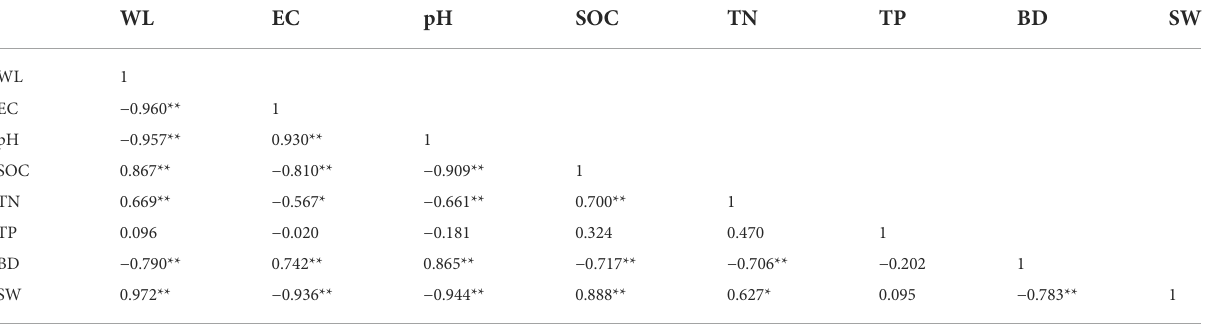
TABLE 2 Pearson correlations between water level, water conductivity, and soil physicochemical parameters.